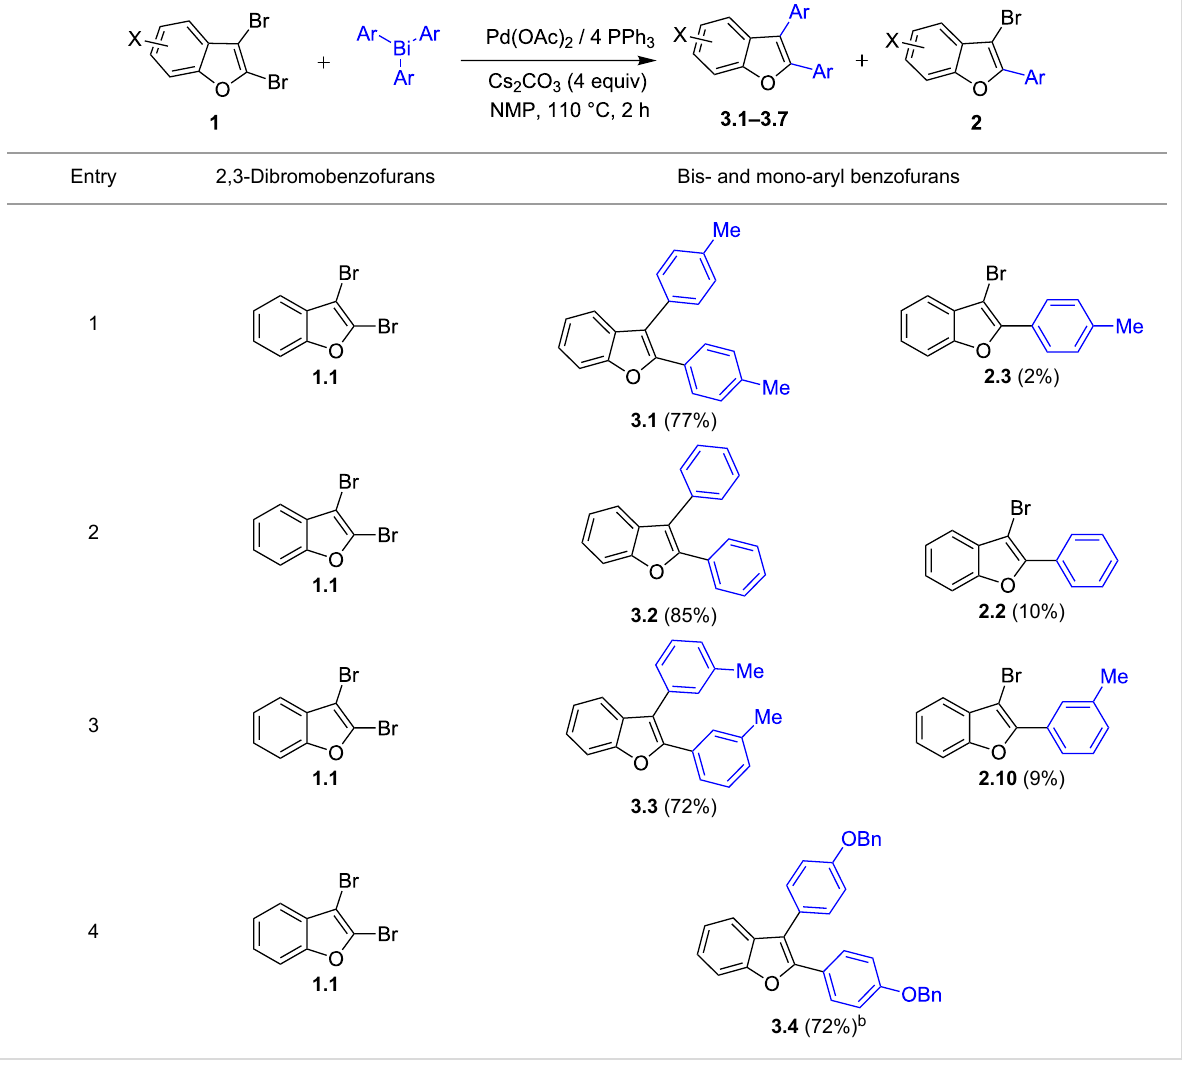
Table 4: Bis-coupling of 2,3-dibromobenzofurans. a